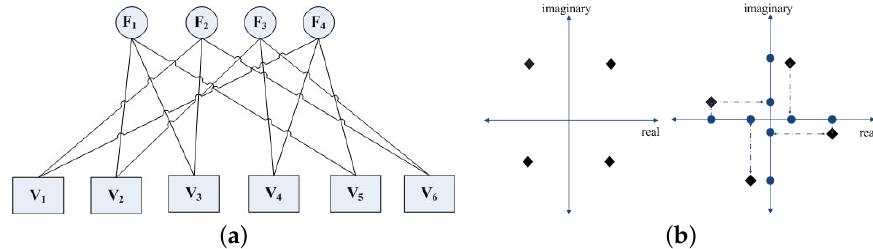
Figure 2. ( a ) Factor graph representation. ( b ) Constellation Rotation for Codebook design in SCMA.